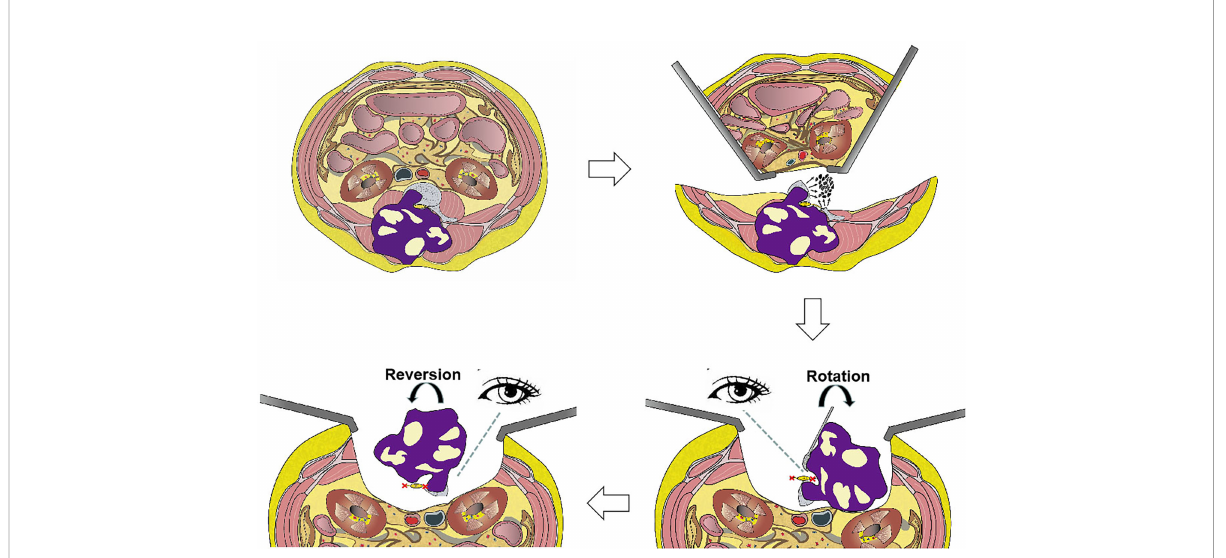
FIGURE 2 Illustration of en bloc resection using the rotation – reversion technique using a combined anterior and posterior approach in the lumbar spine. The retroperitoneal space was entered through a bilateral anterior pararectus approach, and the aorta and inferior vena cava were separated from the diseased vertebral body. The left hemivertebral body and pedicle of the diseased vertebrae were piecemeal removed as a safe window to enter the spinal canal. The mass in the bilateral paravertebral soft tissue that was not in fi ltrated by the tumor was separated using a posterior approach. The dura was separated from the mass, and the bilateral never roots of the diseased vertebrae were sectioned under direct visualization by the rotation technique. Finally, the entire mass was removed posteriorly using the reversion